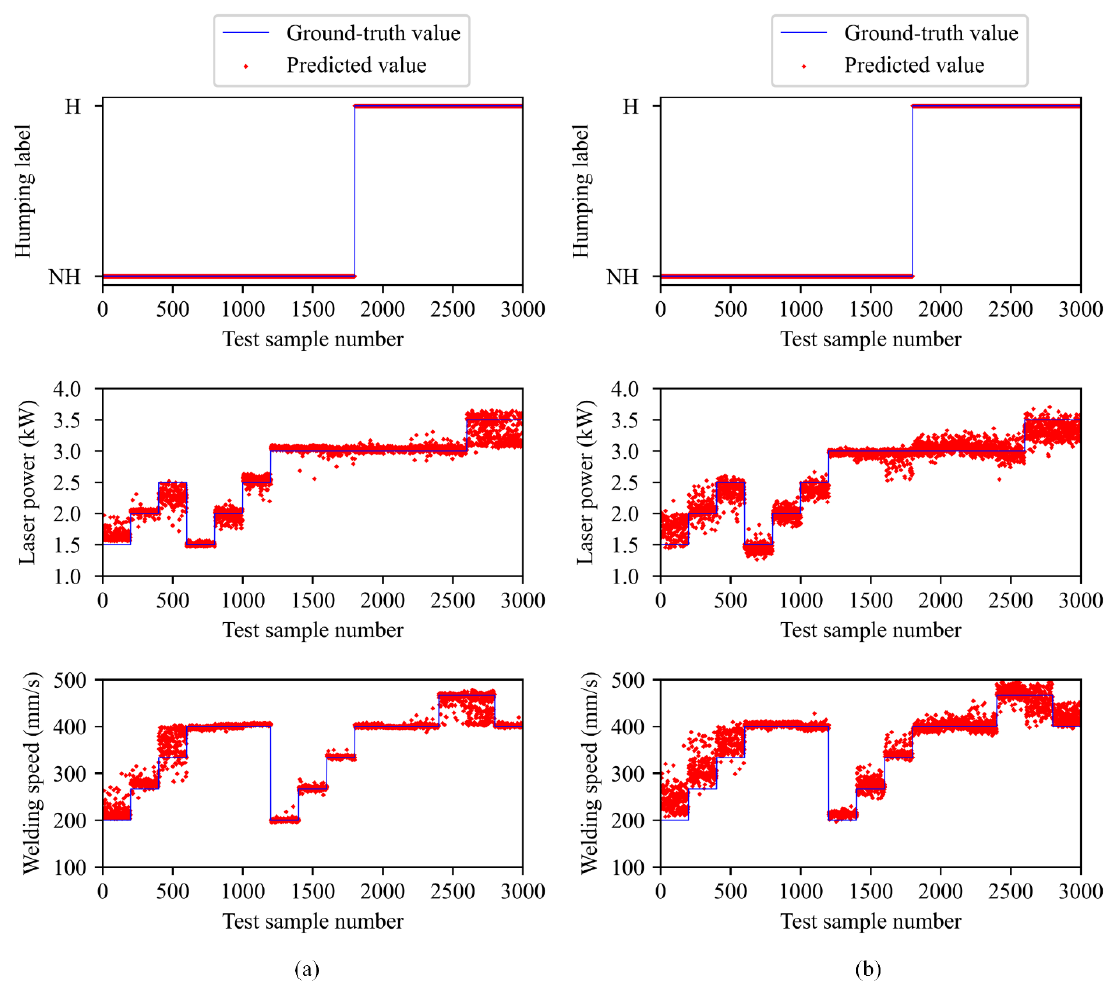
Figure 10. Comparison of the prediction results between ( a ) MobileNetV2-C&R-PSO and ( b ) MobileNetV2-C&R on the test set. (H—humping, NH—no humping).